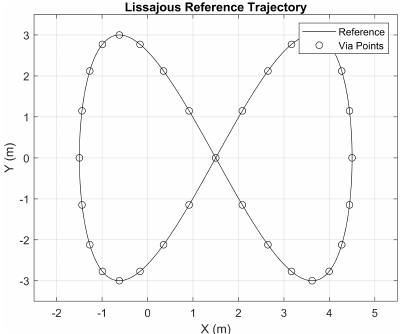
Figure 12. Lissajous curve reference